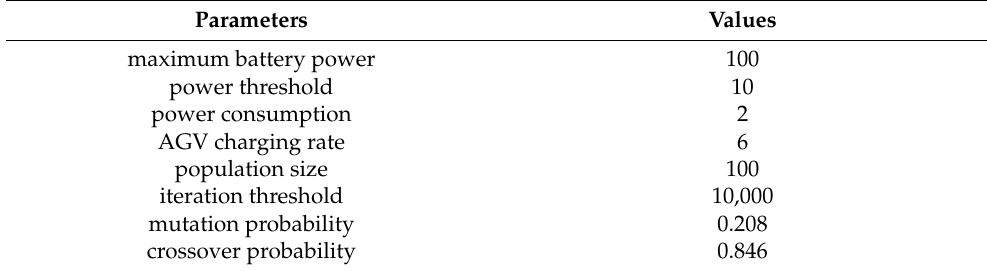
Table 2. The parameters of the algorithm